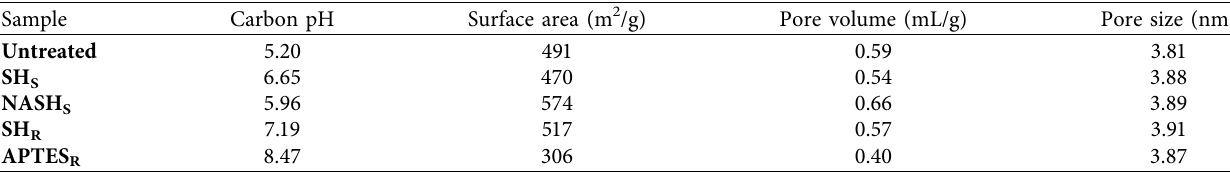
Table 1: Physical properties of the untreated and treated activated